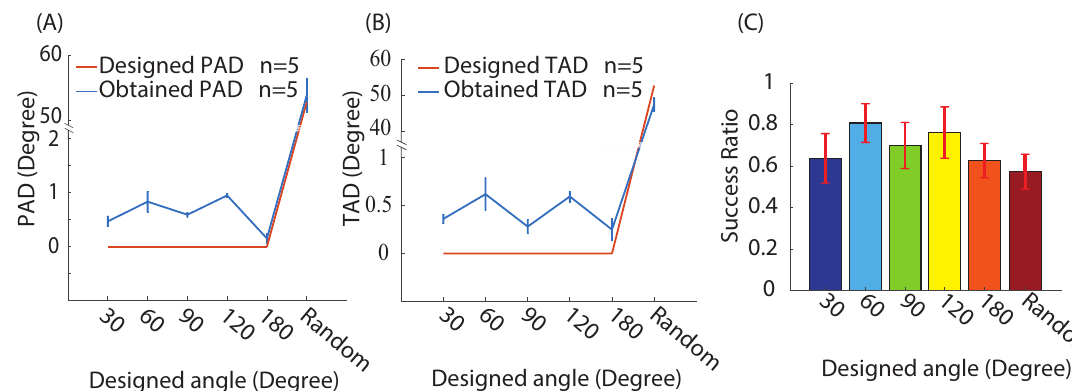
Figure 6. The alignment quantification result of ( A ) PAD and ( B ) TAD. The F-actin alignment deviation (red line) of models with orientation angles of 30 ◦ ∼ 180 ◦ are 0 ◦ , and the alignment deviation is 52.75 ◦ for the random orientation model. The blue line denotes the quantified deviation of the successfully-detected F-actin filaments. The average error between the quantified PAD and the designed PAD of all six models was less than 0.67 ◦ , and it was less than 1.22 ◦ between the quantified and designed TAD. ( C ) The line detection success ratio (i.e., the number of IRAQ detected lines vs. original line numbers) for each